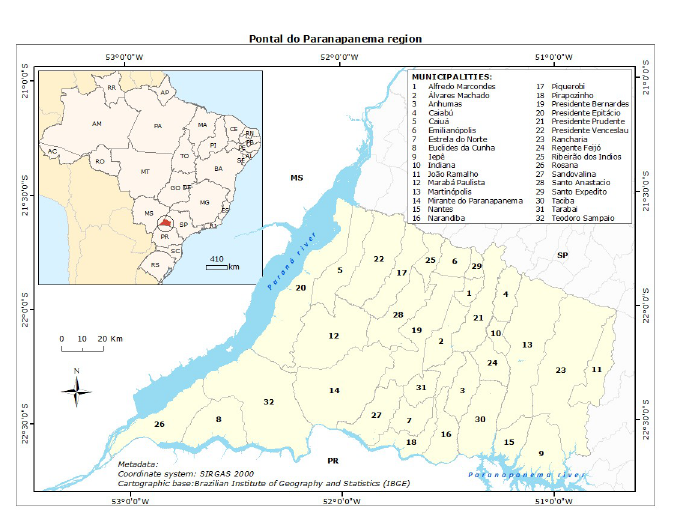
Fig 1. Pontal do Paranapanema location in S ã o Paulo state and Brazil. The region is in the west side of the state, which in its turn, is located in the Southeast of Brazil.